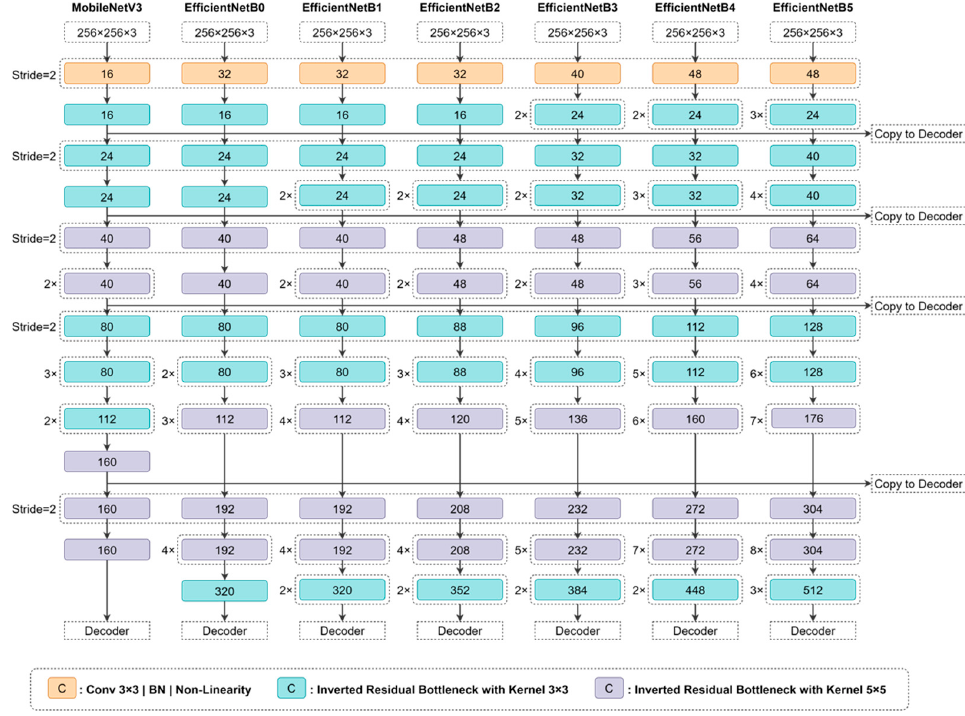
Figure 3. Architecture detail on MobileNetV3 and EfficientNet B0-B5 as the encoder.